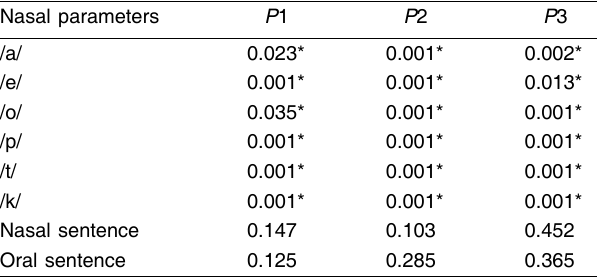
Table 4 P values of the degree of nasality in the vowels /a/,/e/,/o/,/p/,/t/,/k/ nasal sentence and oral